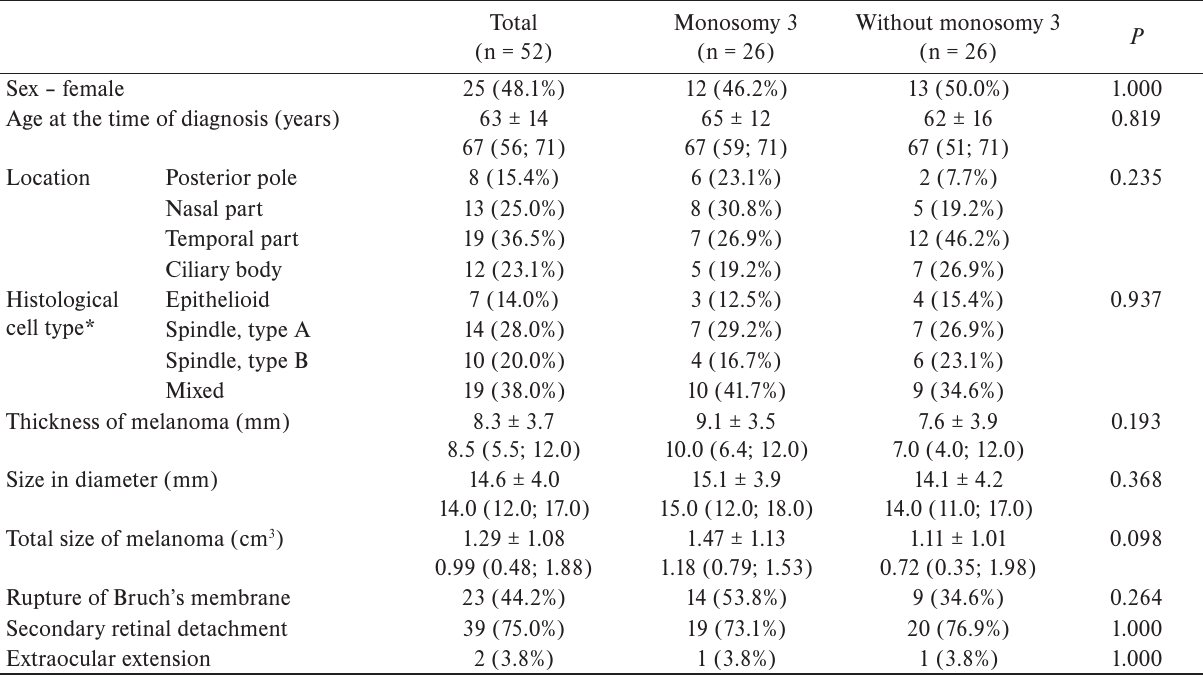
Table 2. Baseline characteristics of patients by abnormalities of chromosome 3.